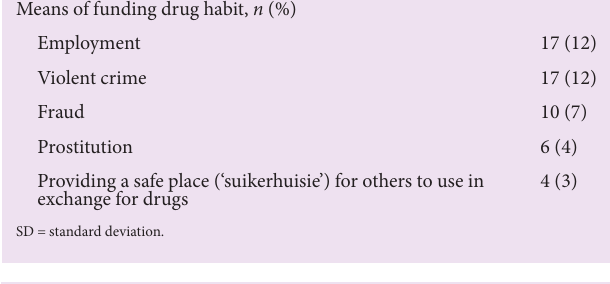
Table 2. Substance use history of participants ( N =141) Age of drug debut, years (mean, (SD))